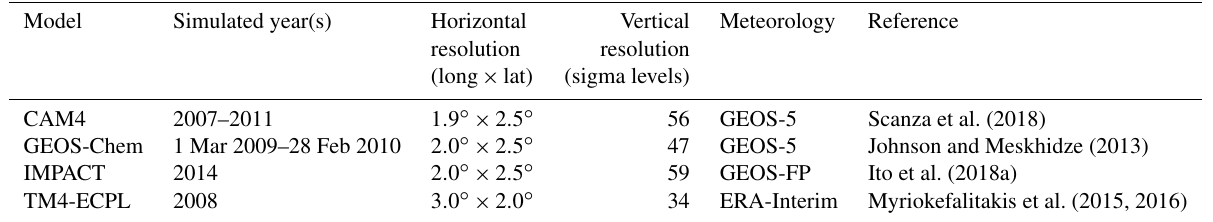
Table 1. General description of the participating models used for the atmospheric Fe simulations. For multiple year simulations, the average was used. Model Simulated year(s) Horizontal Vertical Meteorology